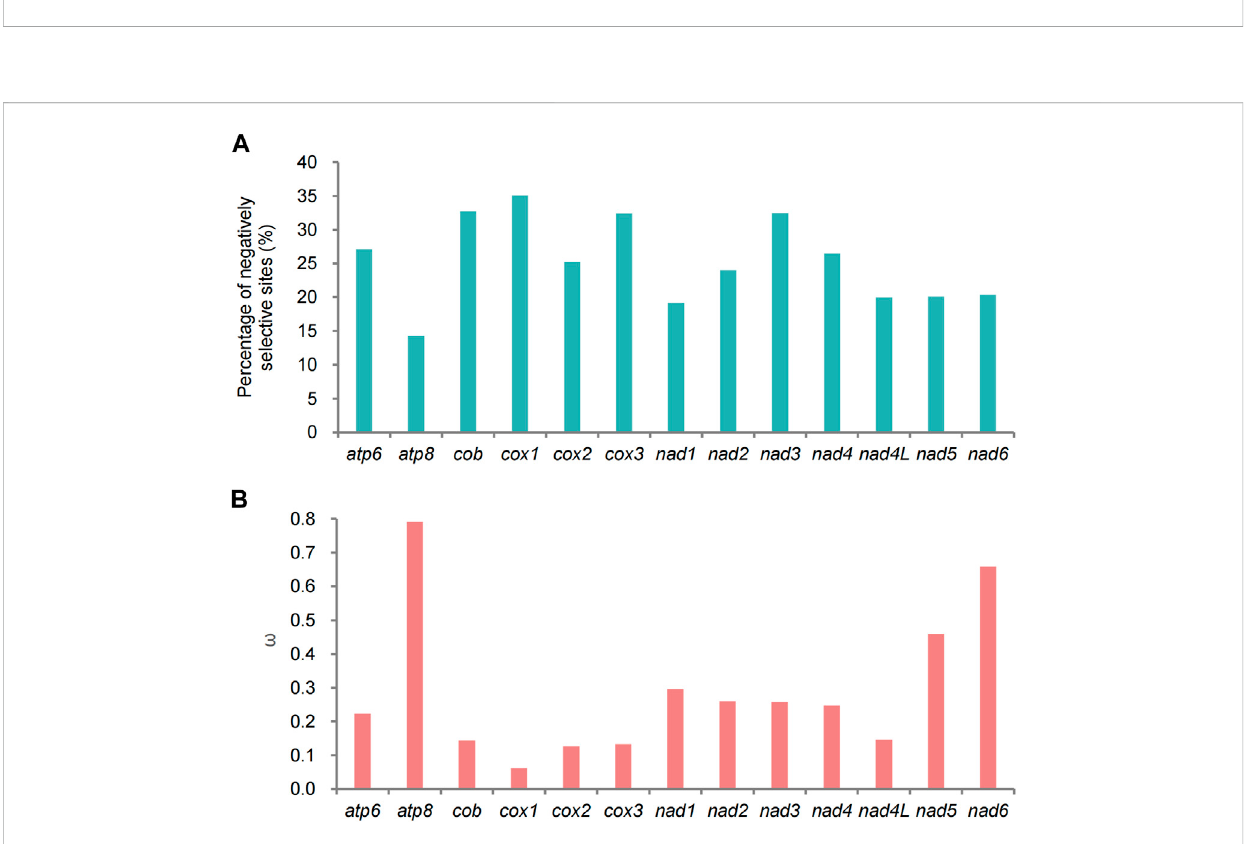
FIGURE 11 Results of selective pressure analyses. (A) Percentage of sites under negative selection in each of the 13 protein-coding genes (PCGs) in Polyommatinae determined by FEL site-by-site analyses. (B) Ratios ( ω ) of non-synonymous substitutions to synonymous substitutions for each of the 13 PCGs in